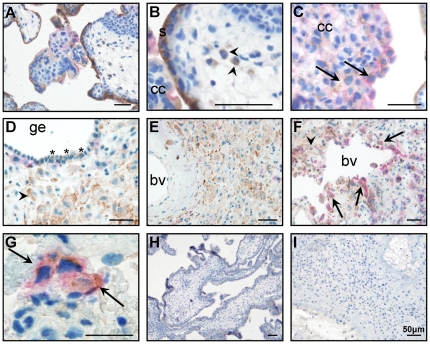
Lysosome associated membrane glycoprotein 1 (LAMP1; brown) and HLAG (pink) co-localization in the placental villous (A–C) and decidua (D–F).A. LAMP1 localization in placental villous. B. LAMP1 localized to the cell column (cc), syncytiotrophoblast (s) and leukocytes in the villous stroma (arrowhead). C. LAMP1 co-localized with HLAG positive cells (arrows) in the cell column (cc). D. The decidual glandular epithelium (ge) was predominantly negative for LAMP1, but LAMP1 immunocolalized to the occasional glandular epithelial cell (*) and to HLAG negative cells in the stroma (arrowhead). E. LAMP1 localized to HLAG negative cells surrounding unremodelled blood vessels (bv). F. LAMP1 localized to EVT (arrows) surrounding remodelled blood vessels (bv). G. LAMP1 and HLAG co-localization (arrows) in the decidua basalis. H. Negative (IgG) control for placental villous. I. Negative (IgG) control for decidua. Scale bar: 50 µm.